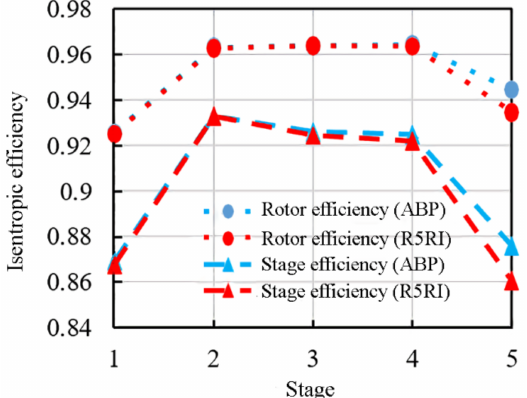
Figure 13. Rotor efficiency and stage efficiency versus stage under peak efficiency